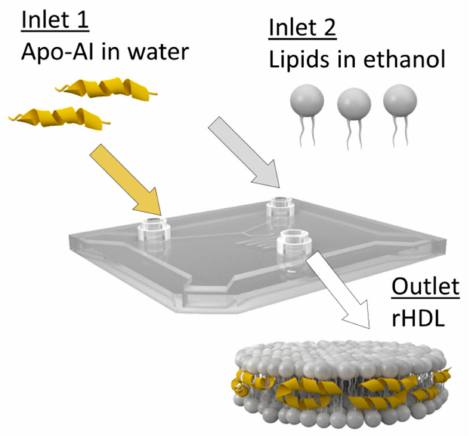
Figure 2. Microfluidic technology for the synthesis of reconstituted high density lipoprotein (rHDL) particles. Using microfluidic devices large amounts of highly homogeneous rHDL nanoparticles can be synthesized in a single step production